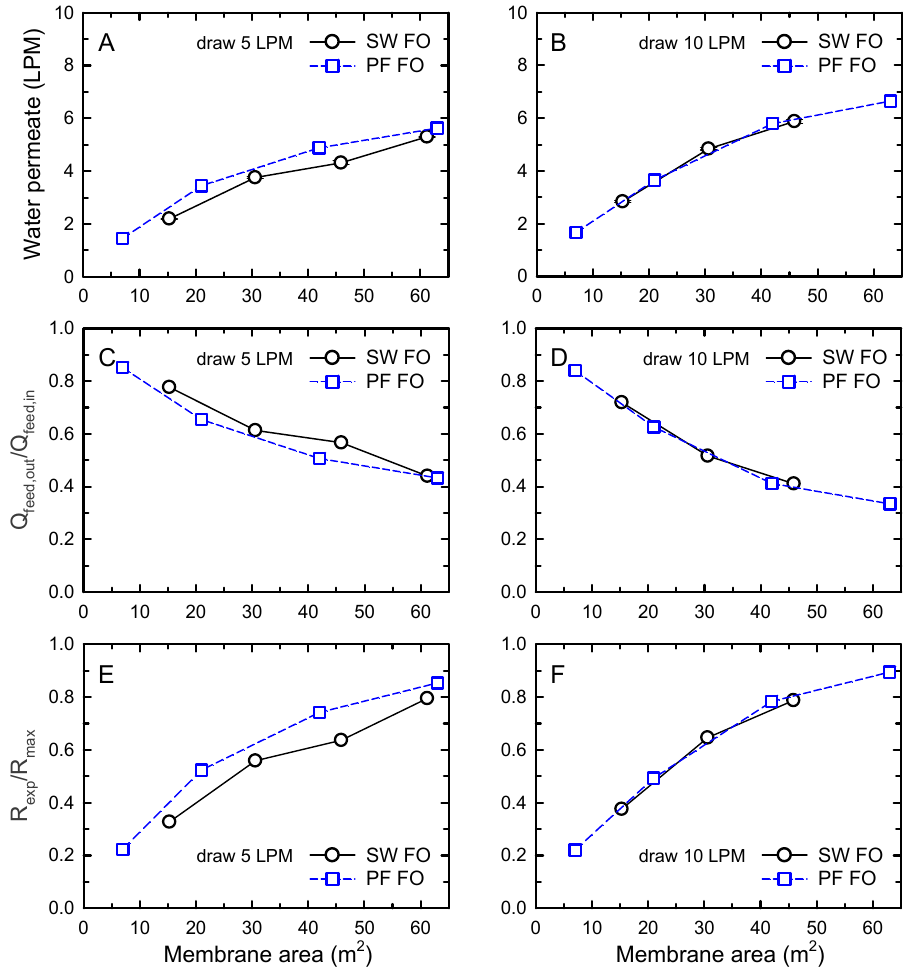
Figure 5. Comparison of FO performance of spiral-wound (SW) and plate-and-frame (PF) forward osmoses (FO) modules. The applied draw solution (DS) flow rates were 5 ( A , C , E ) and 10 LPM ( B , D , F ). The feed solution (FS) flow rates were fixed at 10 LPM. Water permeate (top), normalized feed flow volume ( Q feed, out / Q feed, in ) at the outlet (middle), and performance efficiency ( R exp / R max ) (bottom) as a function of the membrane area. The concentrations of FS and DS were 10 and 70 g/L, respectively.